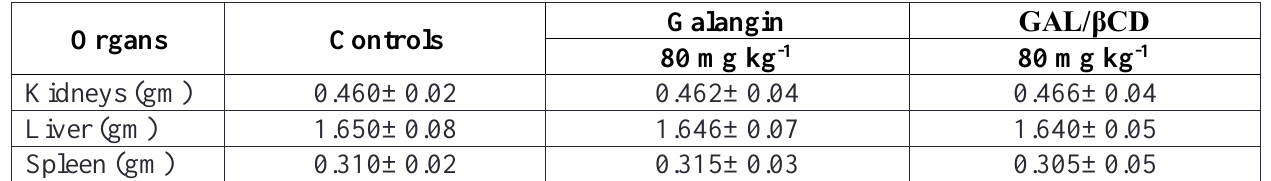
Table 1: Absolute weight of mice organs after treatment with pure galangin and galangin / β-cyclodextrin for 14